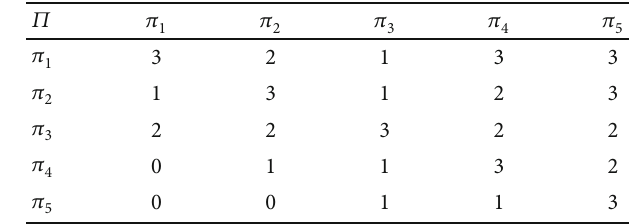
Table 1: The fi rst positive pole membership